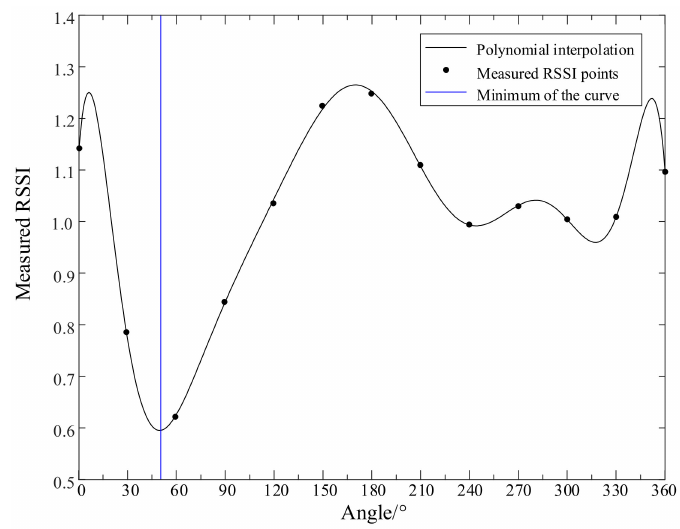
Figure 10. Diagram of polynomial interpolation.